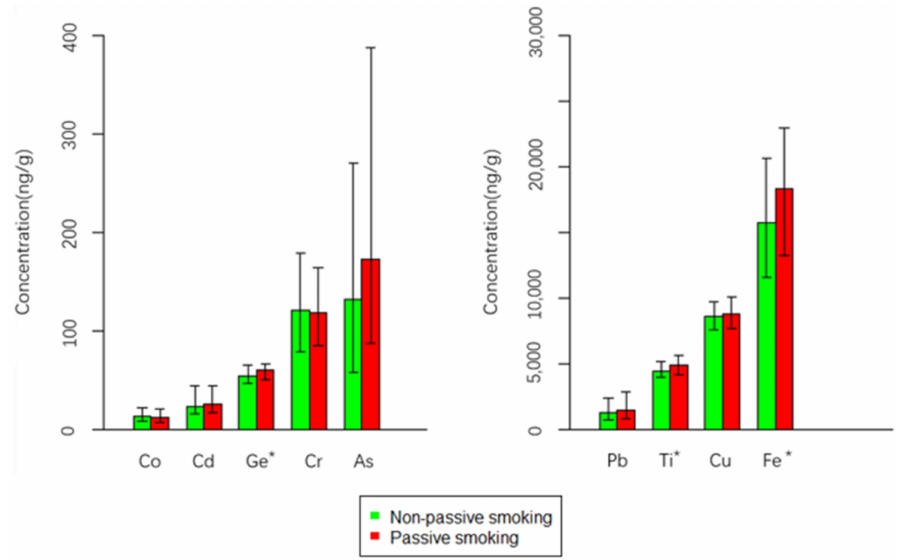
Figure 1. The median and inter-quartile range (IQR) of heavy metal concentrations in passive smokers ( n = 117) and non-passive smokers ( n = 267). *: Significantly different at p < 0.05, according to Mann–Whitney tests.